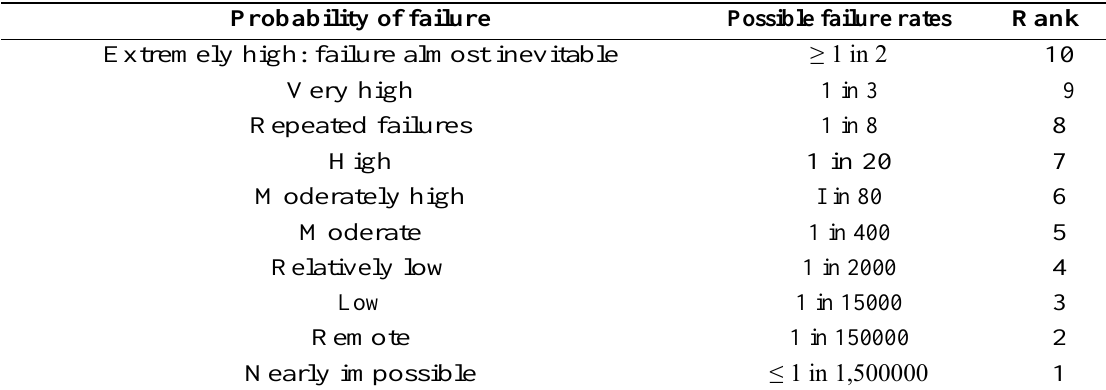
Table 1. Crisp rating for occurrence of a failure